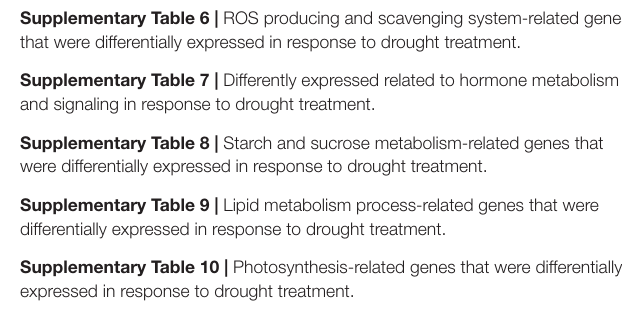
Supplementary Table 11 | Transcription factor families.